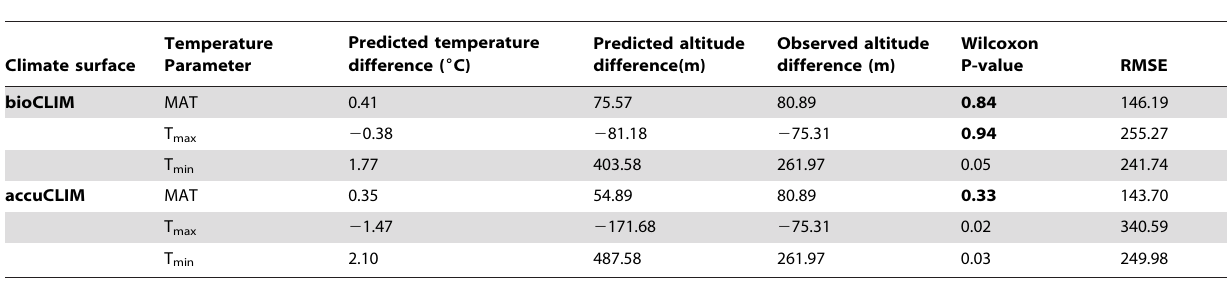
Table 3. Results of Wilcoxon nonparametric tests for differences in location of species’ density optima.